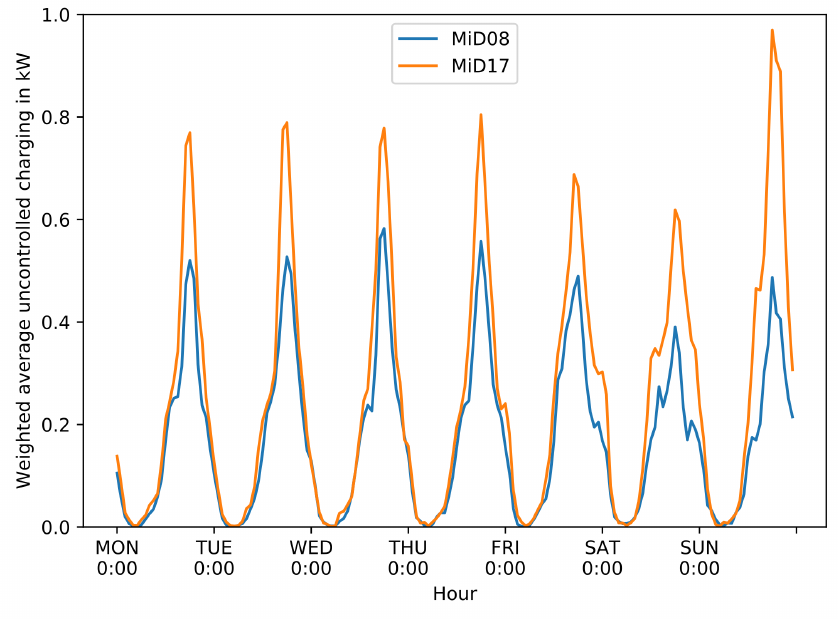
Figure 5. Weighted average uncontrolled charging in kW. Home charging with a capacity of 11 kW is assumed.